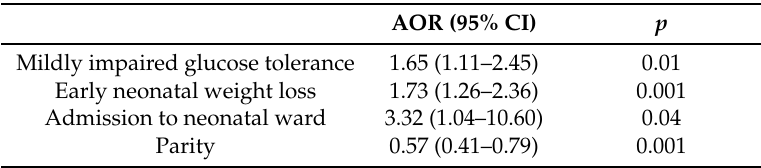
Table 3. Multivariate analysis of factors independently associated with reduction in exclusive breastfeeding